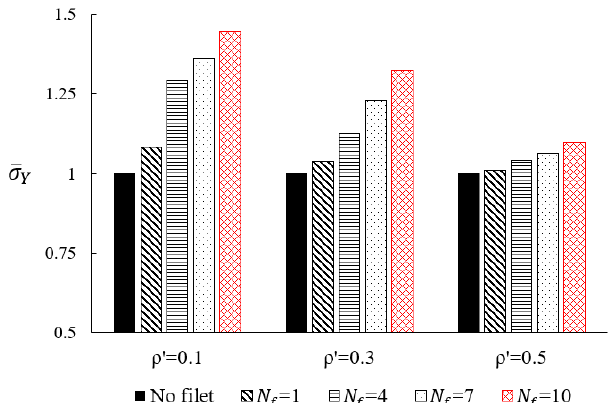
Figure 4. Effect of the fillet parameter, N f , on the normalised effective yield stress, σ Y , of the BCC type lattice at different relative density ( ρ (cid:48) ) levels. At each ρ (cid:48) level, the yield stress values are normalised by the yield stress of the BCC lattice without fillets.